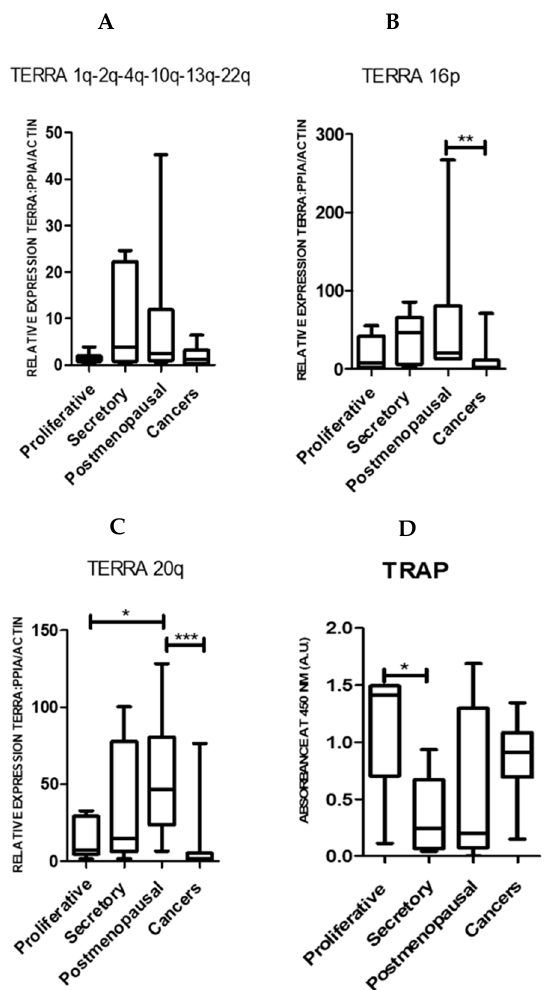
Figure 1. TERRA levels in human endometrium. TERRA levels by qPCR and Telomerase activity by Telomere Repeat Amplification Protocol (TRAP) assay in proliferative ( n = 6), secretory ( n = 8), postmenopausal ( n = 7) human endometrium and endometrial cancers ( n = 24) for: chromosome 1q-2q-4q-10q-13q-22q ( A ); chromosome 16p ( B ); and chromosome 20q ( C ). When compared to age-matched postmenopausal endometrium ( n = 7), women with ECs ( n = 24) showed no changes in TERRA levels for chromosomes 1q-2q-4q-10q-13q-22q ( A ) but a significant decrease in Ch-16p (** p = < 0.002), Mann–Whitney-U test ( B ) and Ch-20q (*** p = < 0.001, * p < 0.05); Mann–Whitney-U test ( C ) but no changes in TA ( D ).